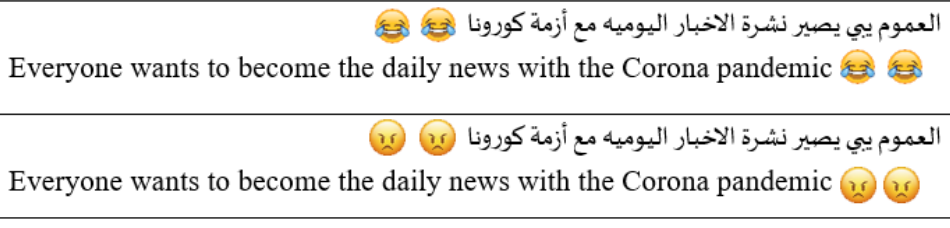
Figure 2. Two Arabic tweets with different